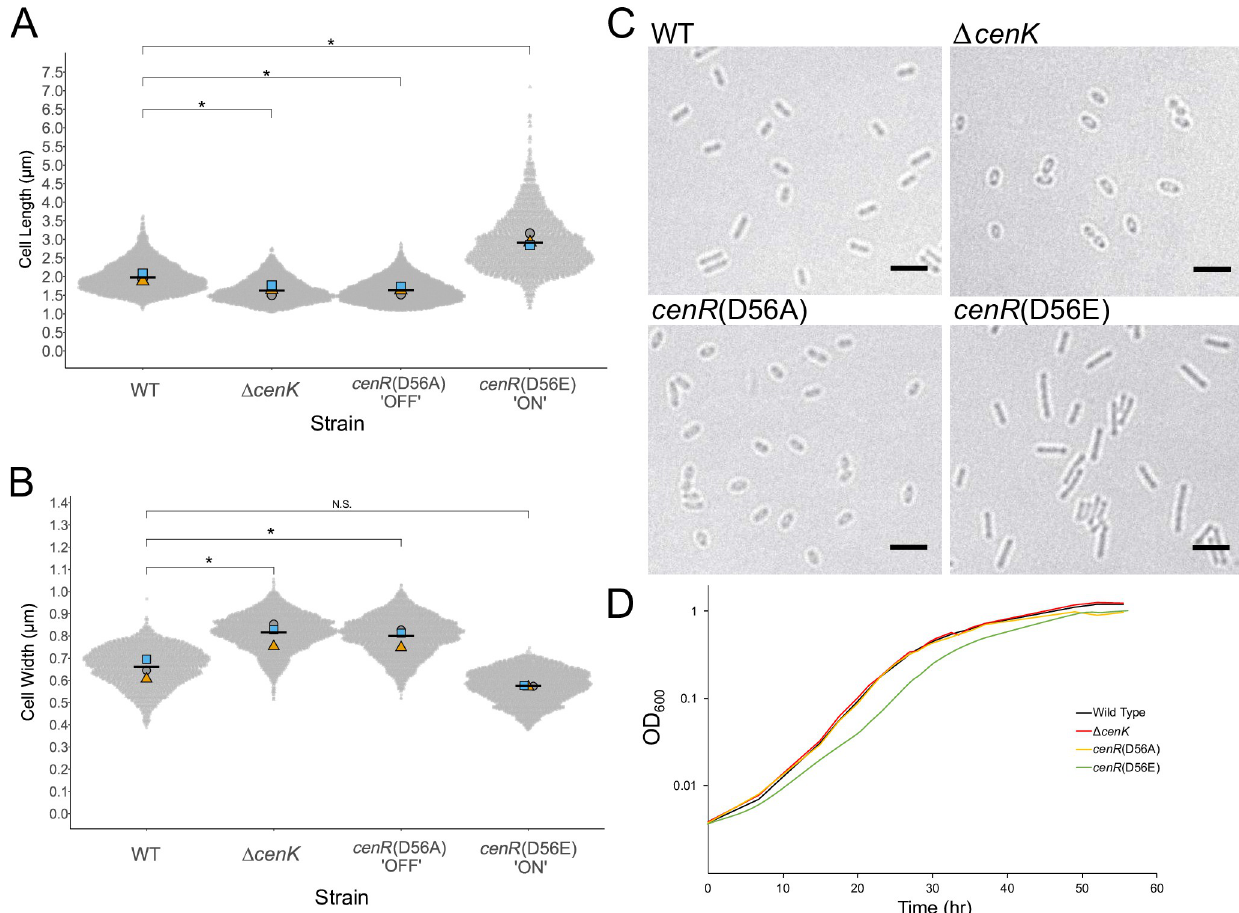
Fig 2. Impact of changes in CenKR activity on cell dimensions. (Panels A-C) Bright-field microscopy measurements of the length and width of exponential phase cells displayed as beeswarms plots [135]. Mean values from each of the three biological replicates (grey circles, yellow triangles, and blue squares, respectively) and mean values for each strain are shown (black bar). For each biological replicate, > 1000 cells were analyzed. Unpaired t-tests were used to compare pooled cell dimension data from the mean values of each biological replicates (n = 3) [133]. Significant P values < 0.05 are indicated by an asterisk. (A) Cell length measurements of wild-type (WT) and indicated CenKR mutants: (mean ± SD) WT = 1.98 ± 0.11 μ m; Δ cenK = 1.62 ± 0.13 μ m; cenR (D56A) = 1.63 ± 0.10 μ m; cenR (D56E) = 2.91 ± 0.17 μ m (see text for explanation of individual alleles). (B) Cell width measurements of WT and indicated CenKR mutants: WT = 0.66 ± 0.04 μ m; Δ cenK = 0.82 ± 0.05 μ m; cenR (D56A) = 0.80 ± 0.04 μ m; cenR (D56E) = 0.57 ± 0.01 μ m. (C) Bright-field microscopy images of wild-type and indicated CenKR mutant strains (scale bar = 3 μ m). (D) Growth curve of Rb . sphaeroides strains. Hyperactivation of CenR results in slower growth rate compared to WT cells (3.5 hours vs 2.5 hour doubling time, respectively).